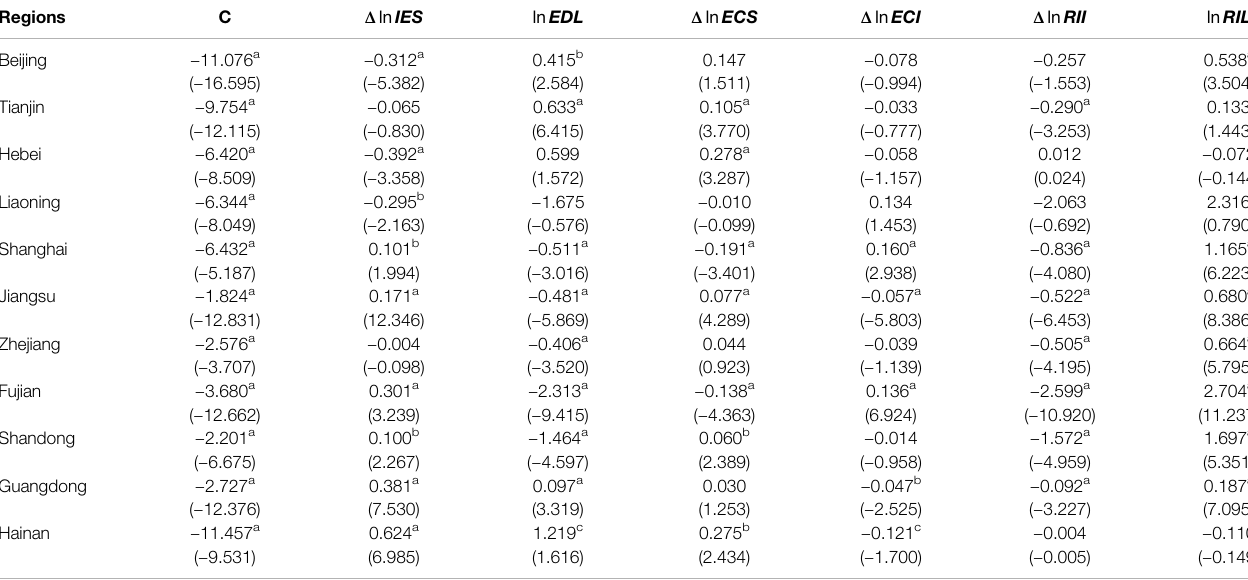
TABLE 4 | Regression coef fi cient test results of in fl uencing factors of TCP.